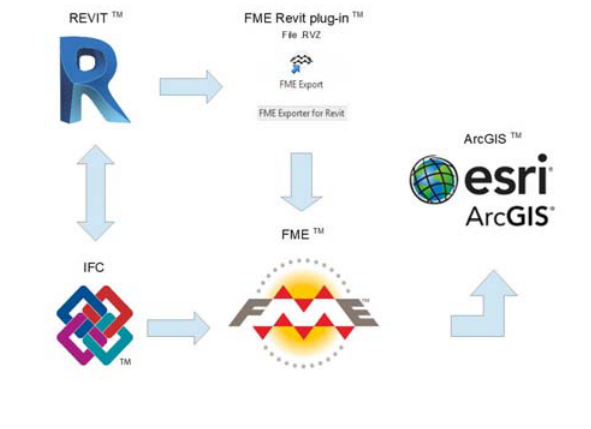
Figure 6. BIM-3D GIS